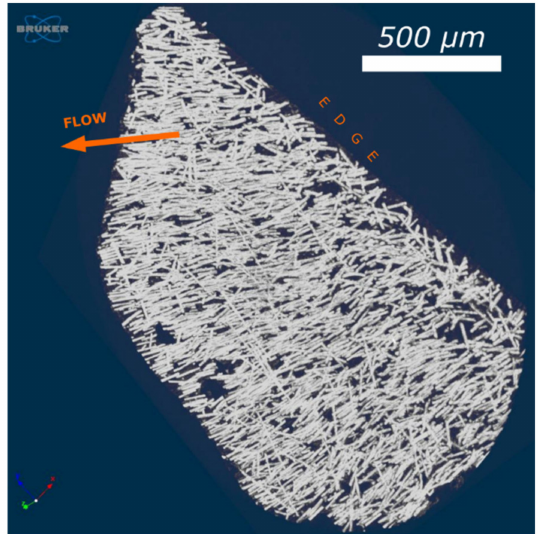
Figure 10. Microcomputed tomography 3D visualization of glass fibers orientation in a sample cut from the edge of 8.4 mm thick molded piece (C8). Polymer melt flow is marked by the orange arrow.